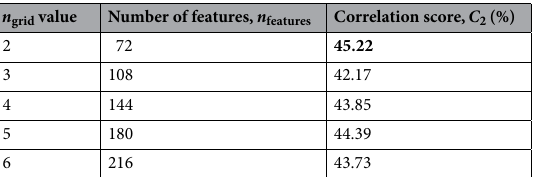
n grid value Number of features,